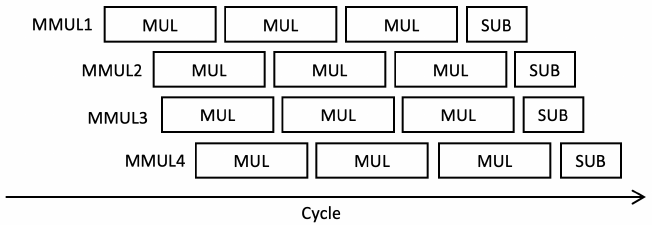
Figure 6. Example of scheduling for four pipelined Montgomery Modular multiplier (pMMM)